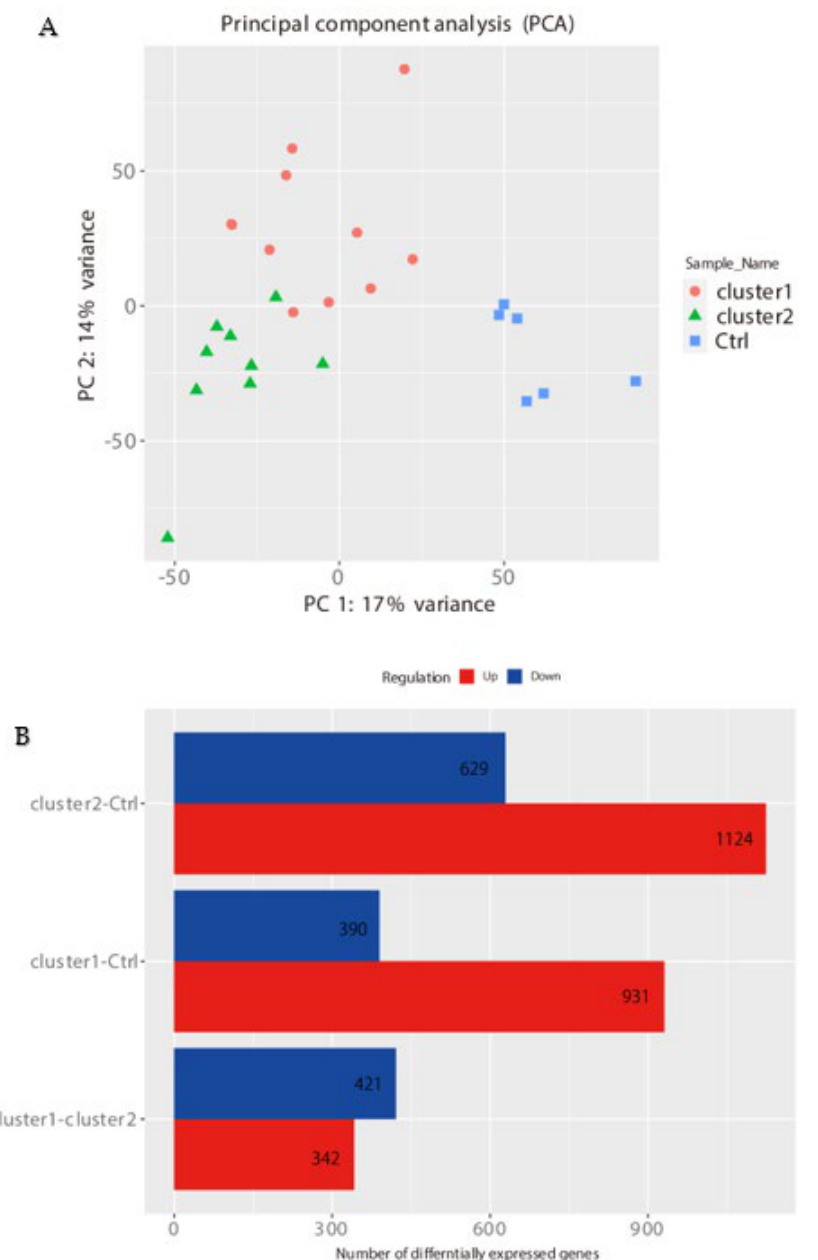
Figure 7. PCA analysis and DEGs of new clusters. ( A ) The new clusters showed clear separation from the control in PCA. ( B ) DEGs were identified not only for both cluster1-Ctrl and cluster2-Ctrl but also for cluster1-cluster2.